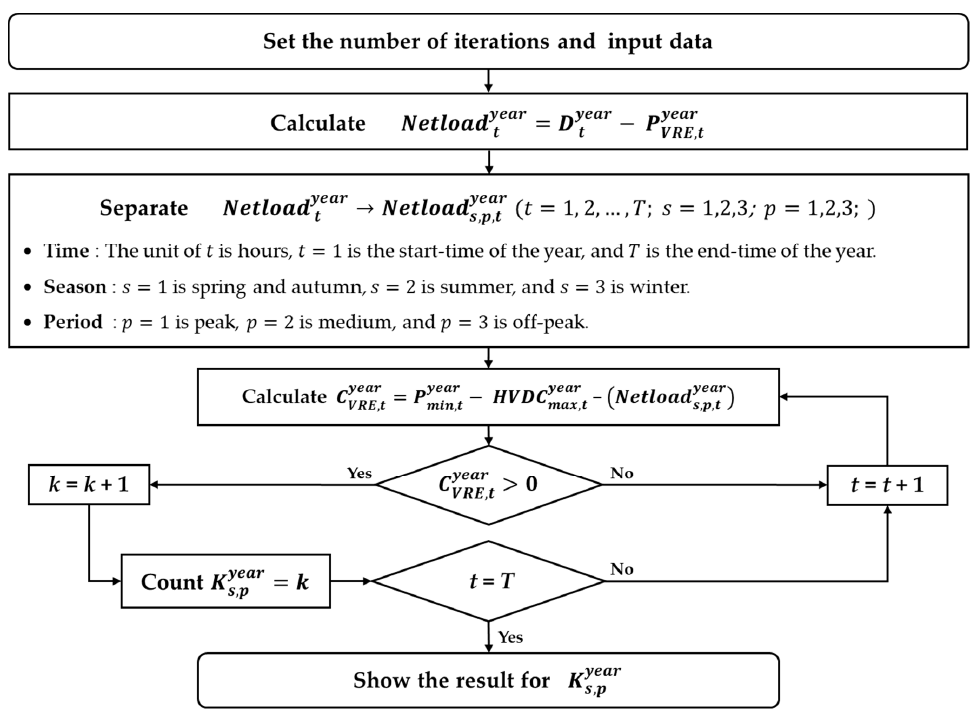
Figure 3. Flowchart for counting the number of VRE curtailments for each season and period.